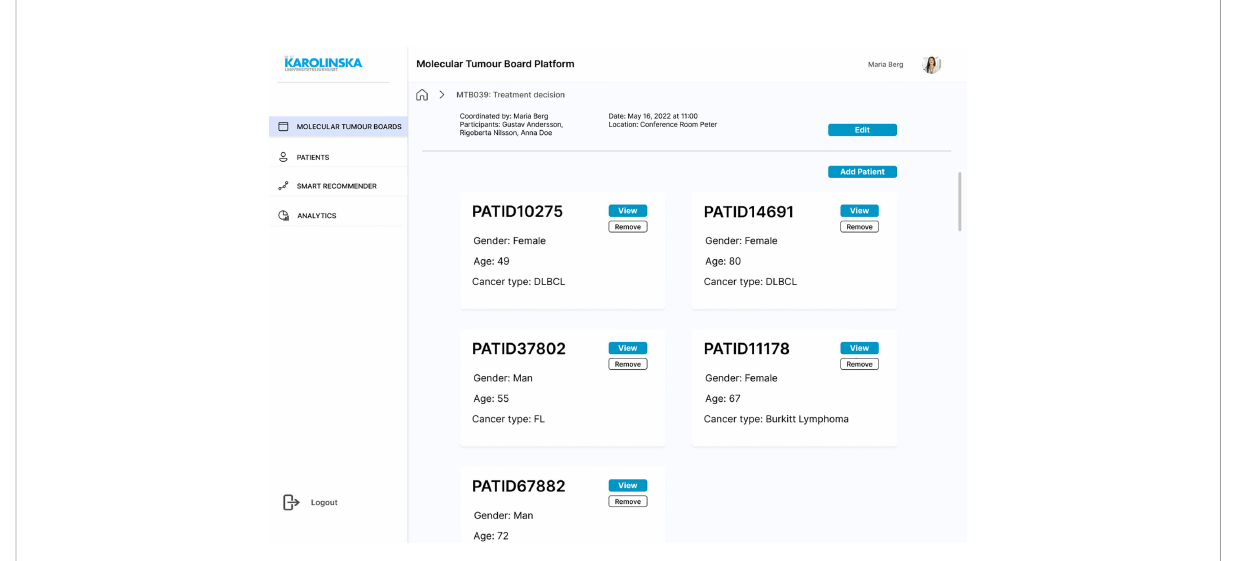
FIGURE 7 Mock-up screen. MTB overview with a list of fi ve new patient cases to discuss.